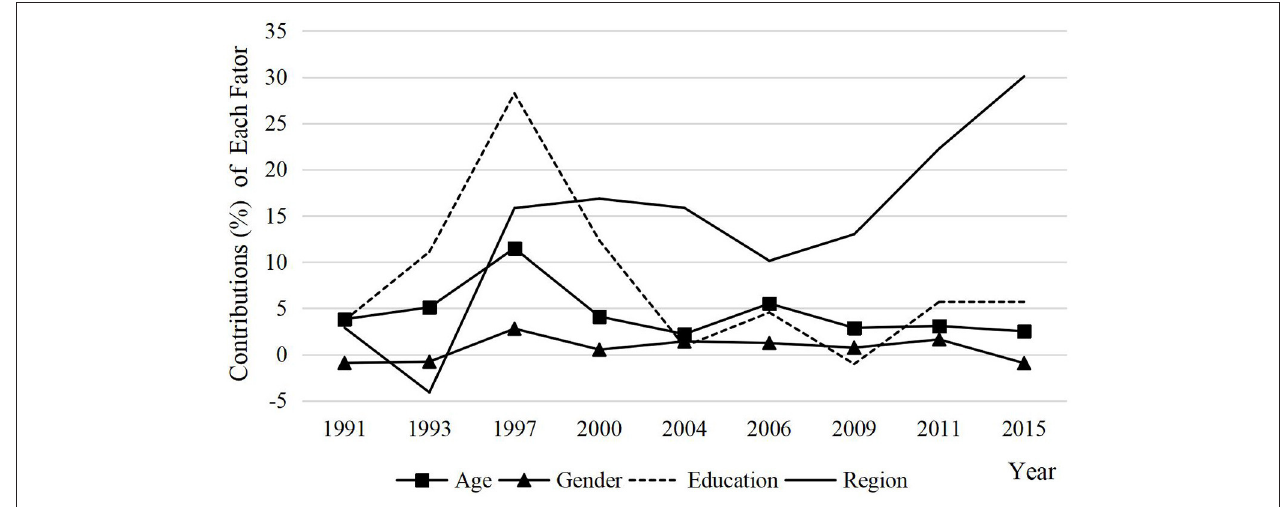
FIGURE 2 | Contributions (%) of each factor in HTN rate of older adults by decomposition,